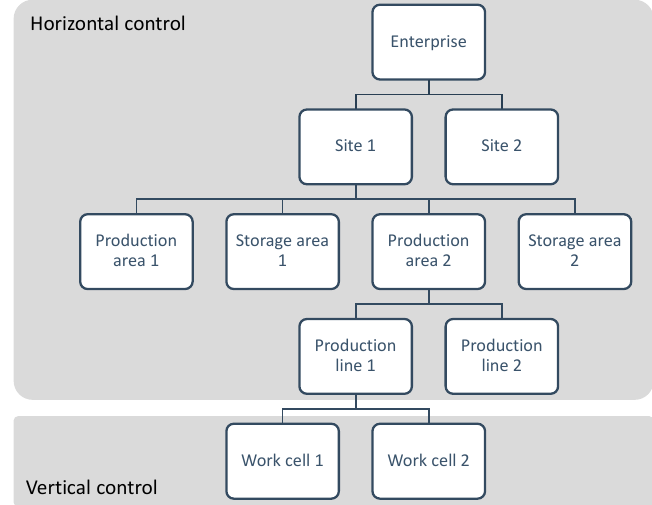
Figure 3. Illustrative physical hierarchy of a manufacturing enterprise showing the different control regimes applied at different levels of the enterprise.